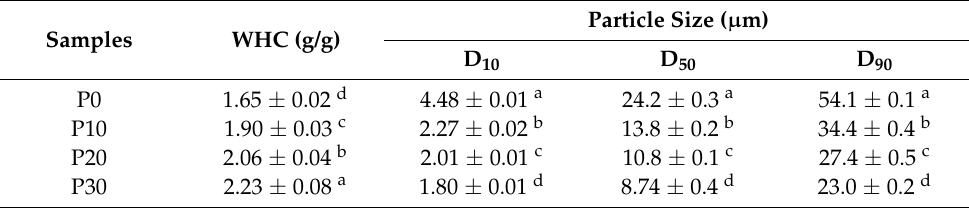
Table 1. Characteristics of rice protein or homogenized proteins.